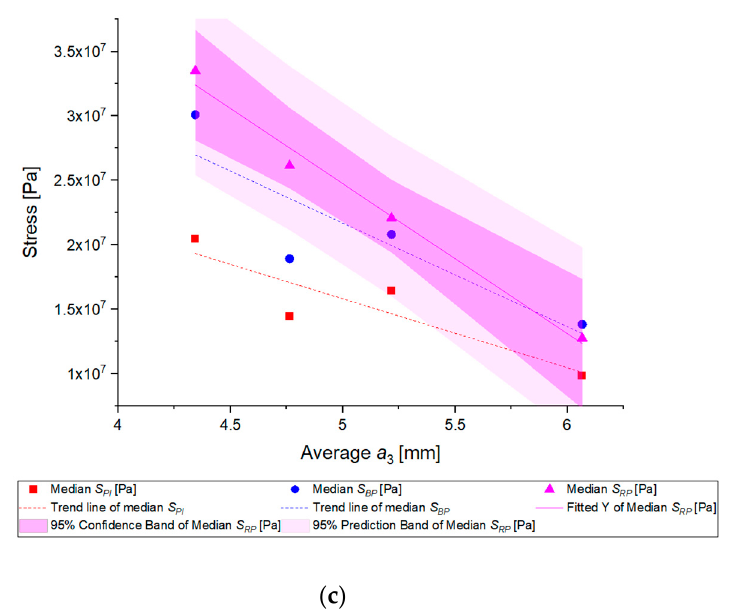
Figure 16. Medians of distributions of the analyzed strength properties in a function of grain mean thickness ( a ) medians of forces values distributions in a function of grain mean thickness, ( b ) medians of specific energy values distributions in a function of grain mean thickness, ( c ) medians of stresses values distributions in a function of grain mean thickness